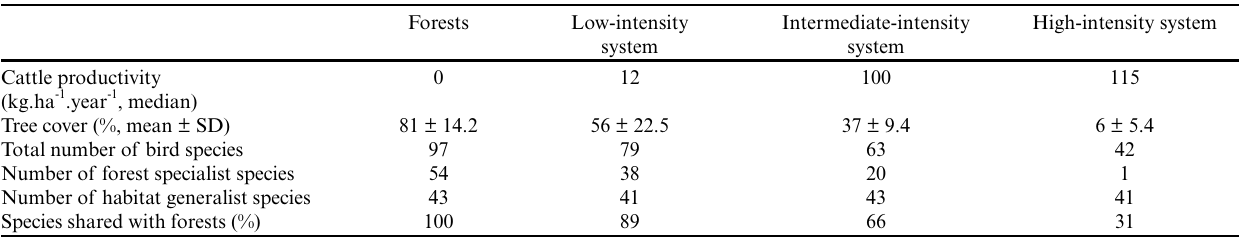
Table 1 . Empirical data used to project conservation and production outcomes under alternative land-use policy